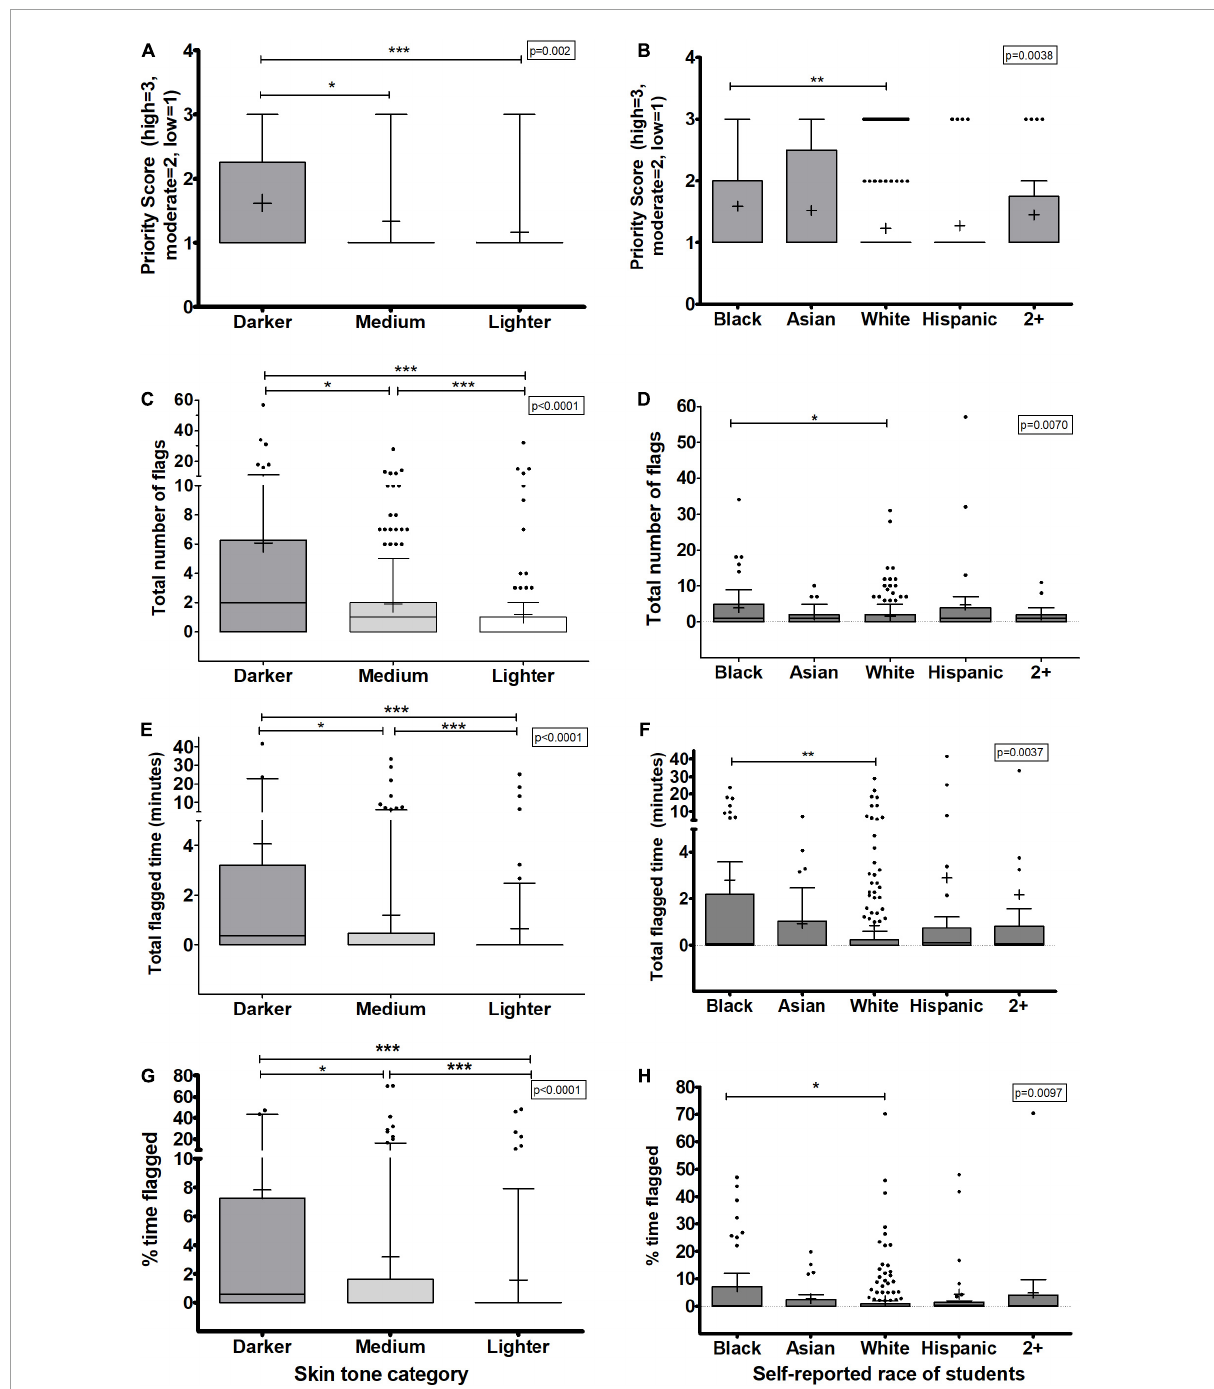
FIGURE1 Overall metrics by the automated test proctoring software based on skin tone classification or self-reported race. (A,B) Priority scores based on skin tone classification are shown with priority scores of 1, 2, and 3 indicating low, medium, and high priority for review. (C,D) The total number of flags given to a student during the assessment. (E,F) The total amount of time during the assessment the student was flagged for any reason. (G,H) Percent of the assessment students spent being flagged by the AI algorithm. (A,C,E,G) Show the data based on the skin tone analysis. (B,D,F,H) Show the data based on student’s self-reported race. Box plots represent 25 and 75% confidence intervals with whiskers represent Tukey’s distributions and dots represent data outliers. Lines inside the boxes represent the median values and + indicate the mean values. Note the divided y -axis scales on some plots to accommodate the wide range of values. Panels (A,B) Chi-squared p -values shown. Panels (C–H) –Kruskal Wallis non-parametric tests yielded an overall p -values indicated on each plot and Dunn’s post-test pairwise comparisons shown with brackets (* p > 0.05, ** p < 0.01, *** p <